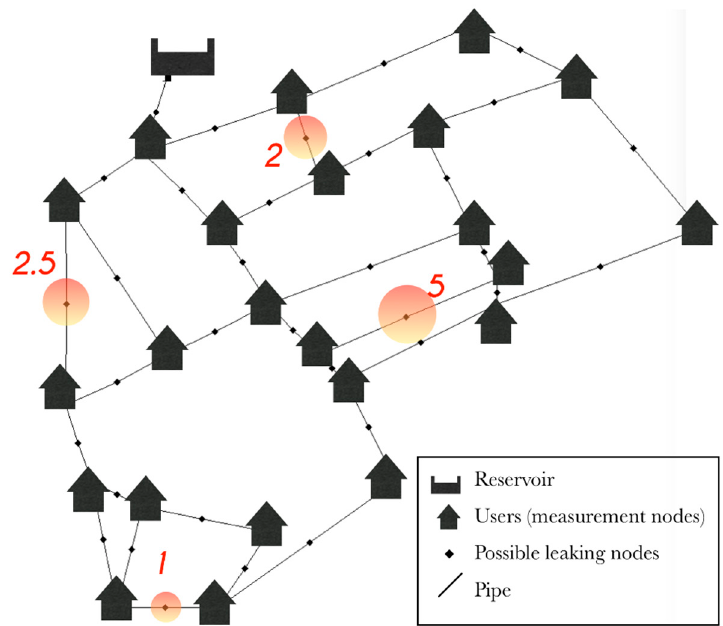
Figure 1. Apulian network layout with the leaking nodes and the correspondent emitter coefficients highlight in red.